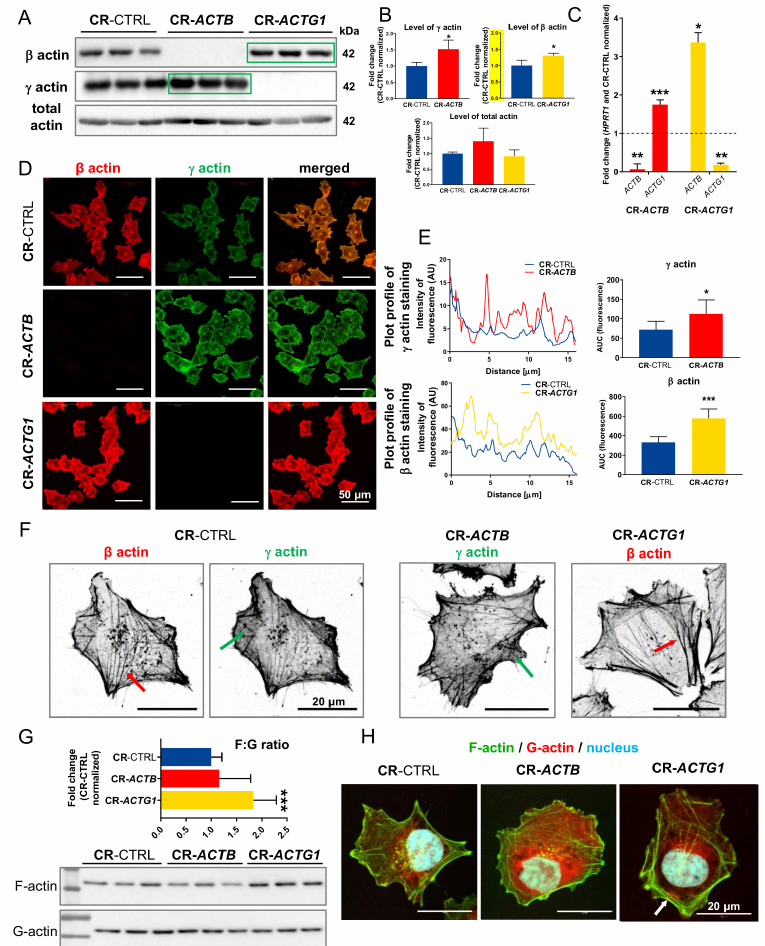
Figure 2. Successful inactivation of ACTB and ACTG1 genes and altered actin cytoskeleton architecture in CR- ACTB [clones with inactivated ACTB with the help of CRISPR / Cas9(D10A) technique] and CR- ACTG1 [clones with inactivated ACTG1 with the help of CRISPR / Cas9(D10A) technique] clones. ( A ) Western blot analysis of control cells and clones without either β or γ actin. To identify isoactins and total actin, appropriate antibodies were used. Corresponding Ponceau S stainings of membranes are shown in Figure S6. Forty µ g of protein was loaded on every lane. Green rectangles represent statistically higher level of protein in comparison to control cells. ( B ) Densitometric analysis of β , γ , and total actin level in tested clones done on membranes shown in ( A ) ( n = 3). ( C ) The qRT-PCR analysis of ACTB and ACTG1 expression level in CR- ACTB and CR- ACTG1 clones ( n = 9). ( D ) Clones devoid of β or γ actin were immunostained with antibodies recognizing non-muscle actins. All pictures were taken at the same settings used during microscopic observations. Pictures of two other clones for every condition are shown in Figure S4. ( E ) Representative plots presenting fluorescence distribution of stained isoactins in tested clones shown in ( D ). Quantitative analysis of area under curve (AUC) from plots ( n = 6). ( F ) Clones were immunostained with anti- β and anti- γ actin antibodies to show cellular distribution of both isoactins. Red arrows point at stress fibers and green ones at actin mesh. ( G ) Western blot analysis of filamentous and globular actin levels in clones without β or γ actin growing on coverslips for 72 h. Nitrocellulose membranes were incubated with mouse anti-total actin antibodies. Quantitative estimation of filamentous ( F ) to globular ( G ) ratio ( n = 8–9). ( H ) Clones were stained with fluorescently labelled phalloidin and DNase I to detect F- and G-actin. White arrows highlight F-actin accumulation. Results are expressed as the mean ± SD ( B , E , G ) or ± SEM ( C ), p ≤ 0.05 (*), p ≤ 0.01 (**), p ≤ 0.001